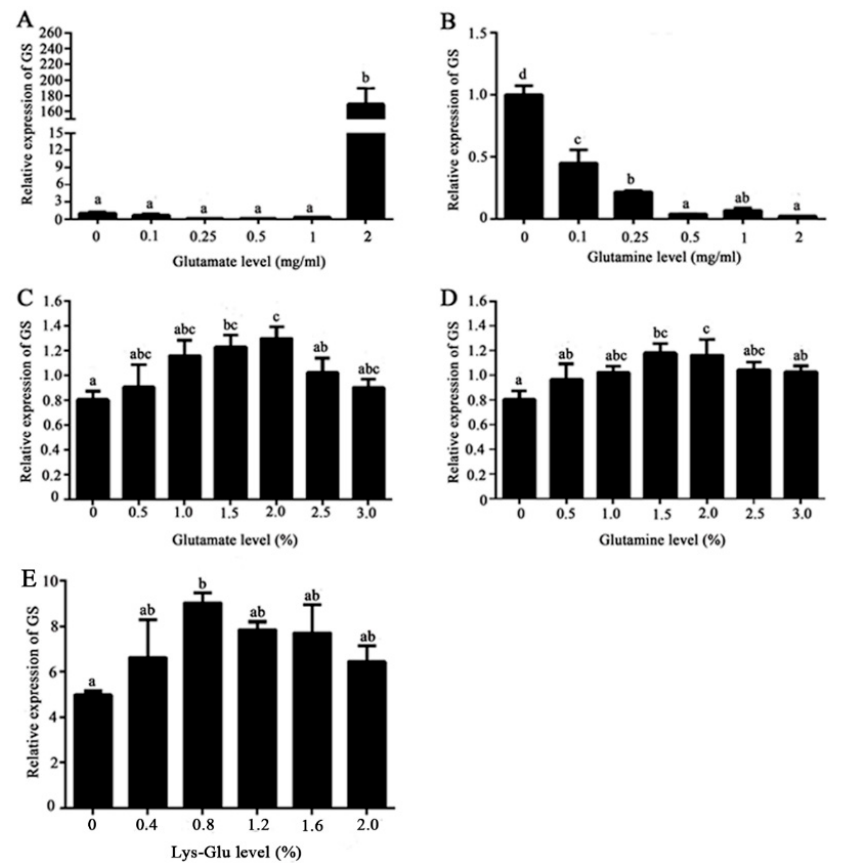
Figure 3. Effects of glutamate, glutamine, and Lys-Glu on GS mRNA expression in vitro and in vivo. ( A , B ) Effects of glutamate ( A ) and glutamine ( B ) on GS mRNA expression in vitro; ( C – E ) effects of glutamate ( C ), glutamine ( D ), and Lys-Glu ( E ) on GS mRNA expression in vivo. Error bars indicate the mean ± SD. Tukey’s multiple range test was performed and different letters represent significant differences ( p < 0.05, n = 3 for each group).